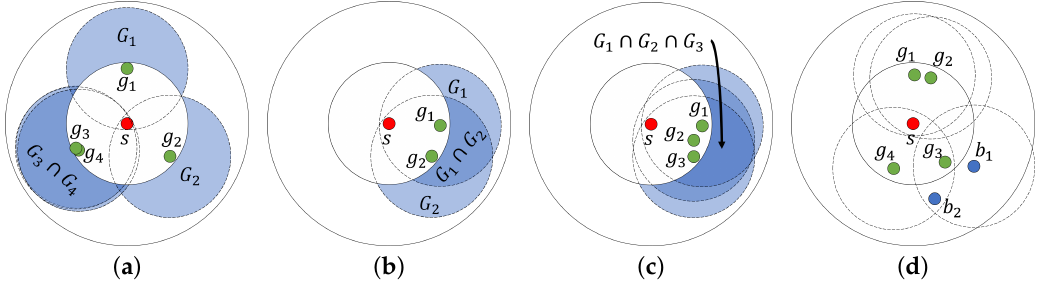
Figure 2. The broadcast storm problem under various network statuses: ( a ) non-overlap and full-overlap, ( b ) partial overlap (two nodes), ( c ) partial overlap (three nodes), and ( d ) collisions and